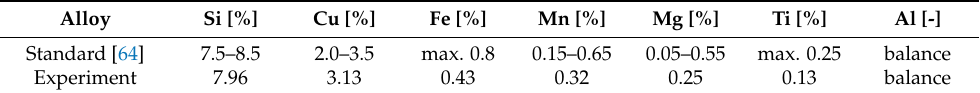
Table 1. Nominal chemical composition of the investigated cast alloy EN AC-46200 in weight percent.